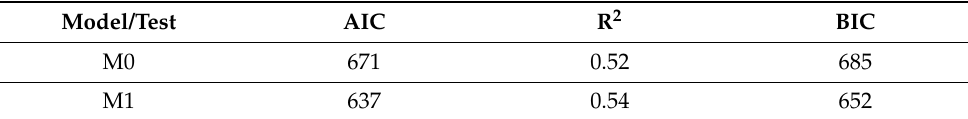
Table 3. Specification of the model using AIC, R 2 and BIC tests.